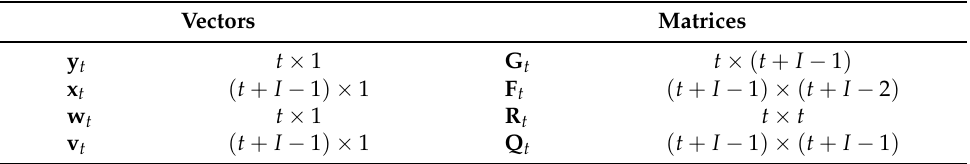
Table 5. Dimensions in the state space model of Li (2006). Vectors Matrices y t t 1 G t t ×